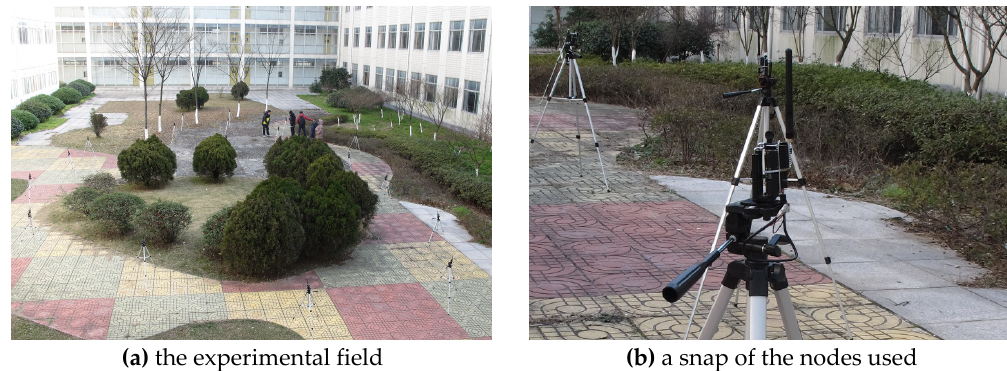
Figure 10. The real experimental scene.